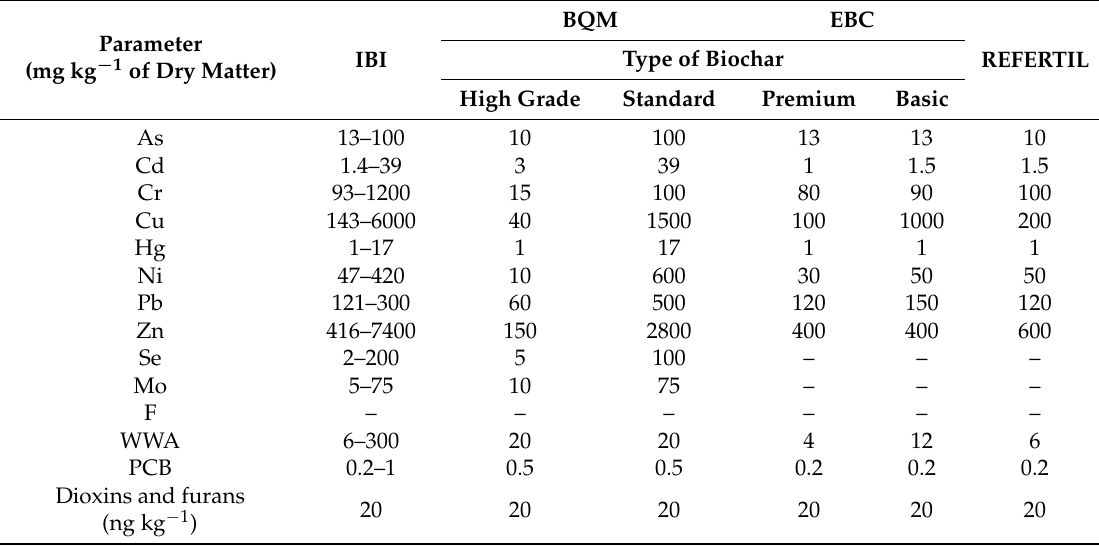
Table 3. The permissible content of contaminants in biochar, based on the existing quality